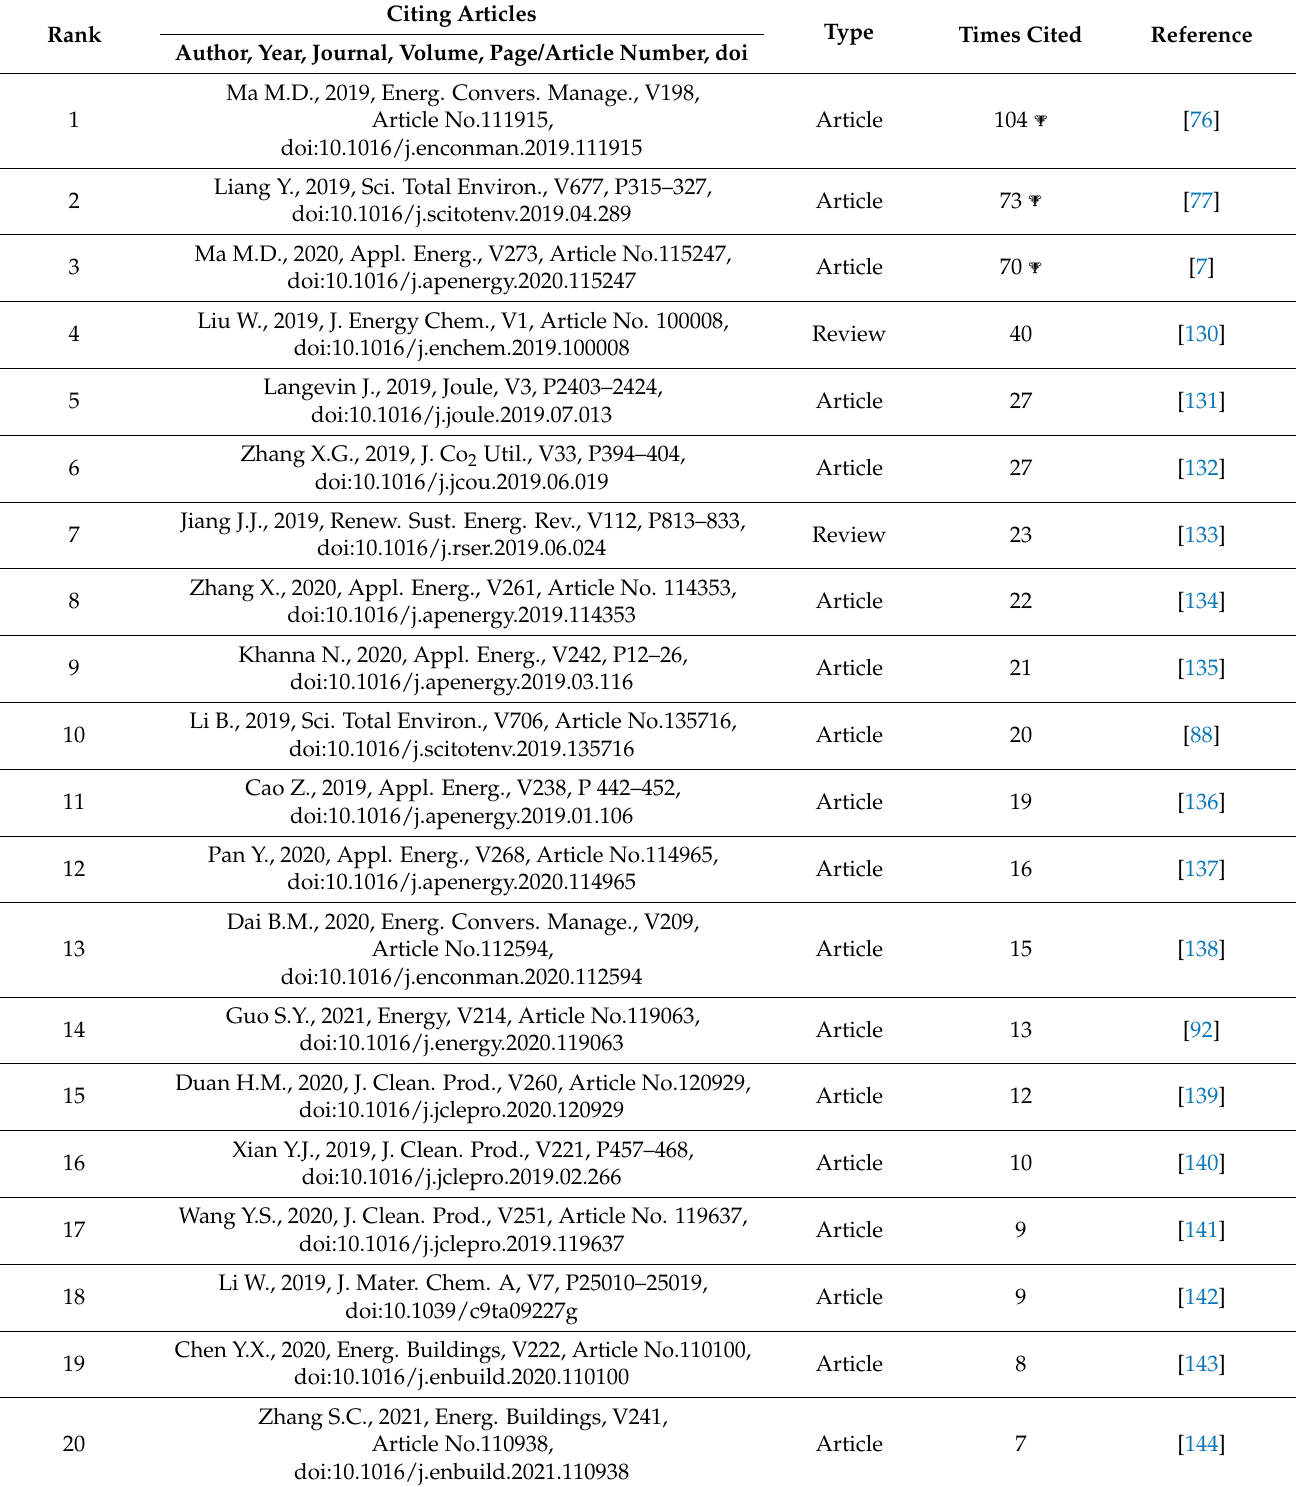
Table A1. Citing articles of ‘Zhou N., 2018, NAT. ENERGY, V3, P978, doi:10.1038/s41560-018-0253-6′.